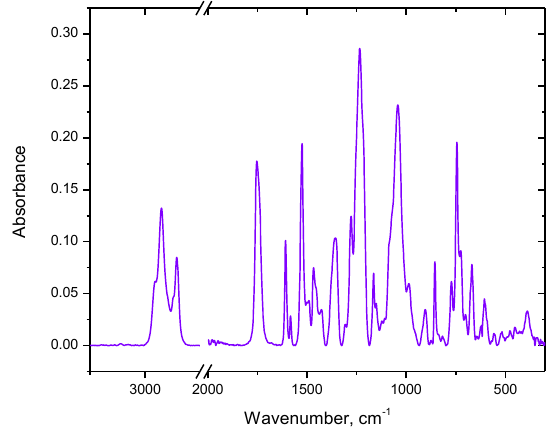
Figure 3. FT-IR spectra of PIM with 1–hexyltriazole. Table 4. Indicated bonds in PIM with 1-hexyltriazole. Range of Wavenumbers, cm − 1